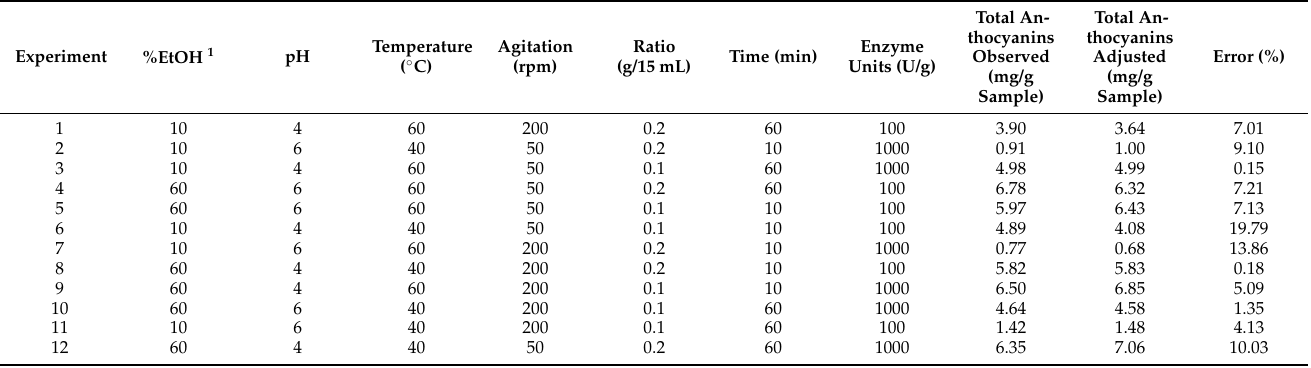
Table 1. Experimental extraction conditions and total anthocyanins values obtained and adjusted to the 12 Plackett–Burman tests with seven variables.